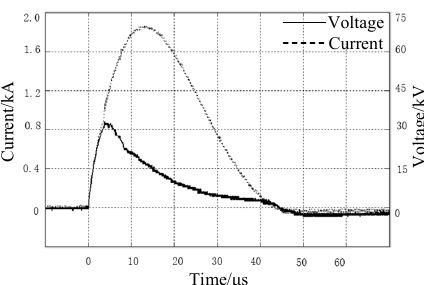
Figure 21. Current and voltage waveform of modified soil with the water content of 15% when injected into the impulse current.